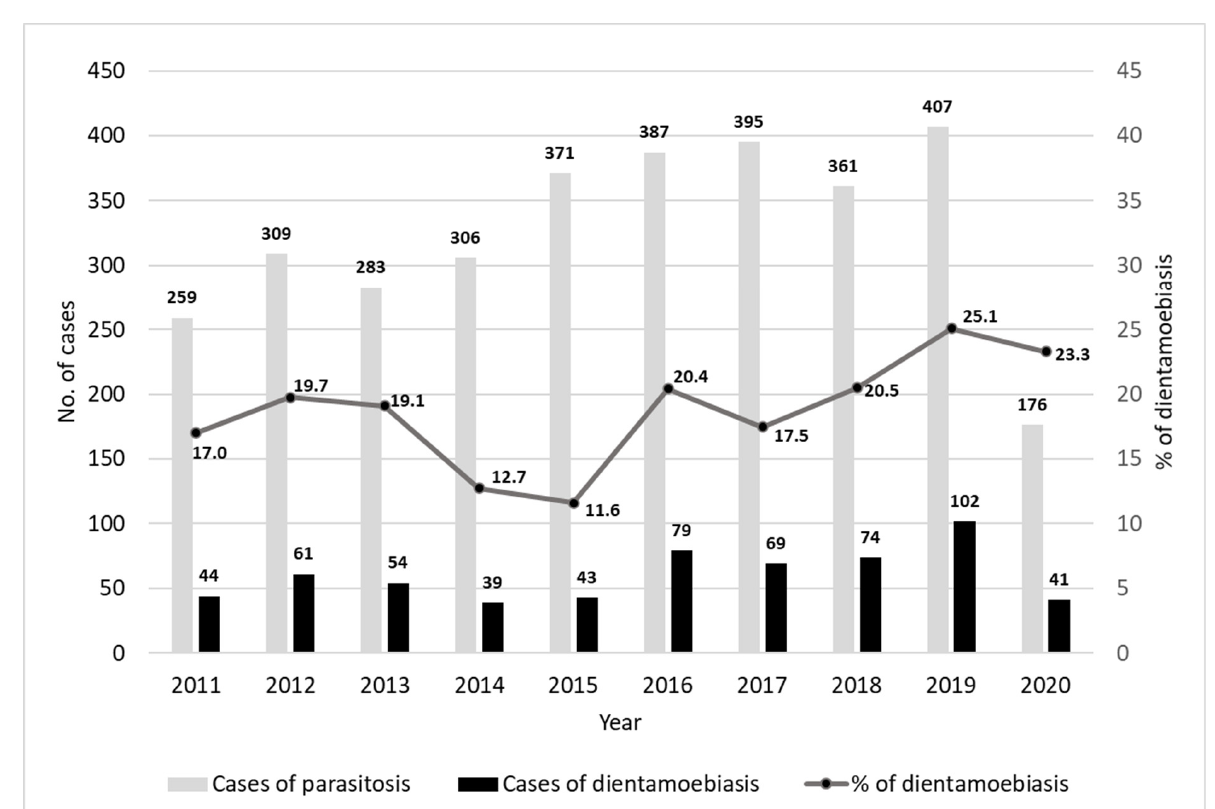
Figure 2. Distribution of cases and frequency of dientamoebiasis per year.